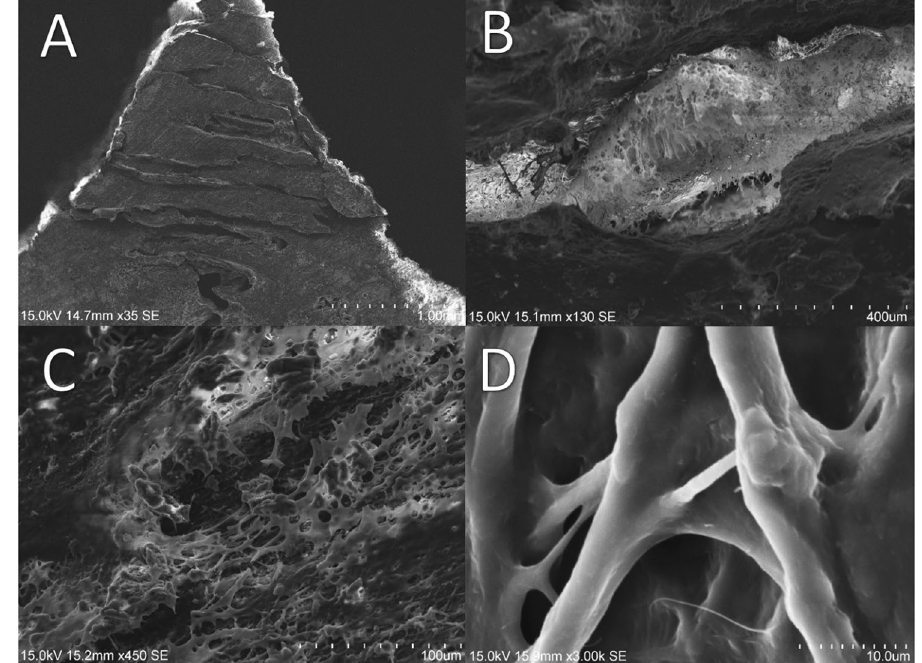
Figure 3. SEM images showing the coronal plane (rostro-caudal view) of a specimen from the maxillary region. The general view (35 × ) illustrates the highly interdigitated suture along the triangular-shaped bone with the base facing the oral cavity, and the apex oriented towards the nasal cavity for connection with the vomer ( A ); bone-ligament-bone interface (130 × ), ( B ); sutural ligament (450 × ) ( C ); detail of sutural ligament fibres (1000 × ) ( D ).